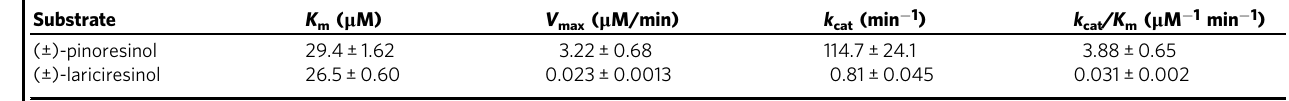
Table 2 Kinetic properties of Ii PLR1_V46A.